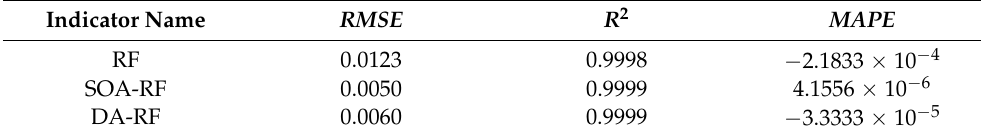
Table 5. SOA-RF model performance indicators.